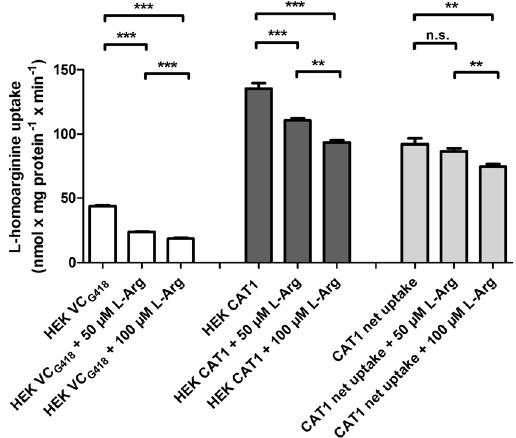
Figure 5. Inhibition of L-homoarginine uptake by HEK CAT1 cells and respective control cells (HEK VC G418 ) and resulting CAT1-mediated net uptake without and with co-administration of L-arginine in physiological concentrations. Each data point is n = 6, mean ± SEM, *** p < 0.001, ** p <